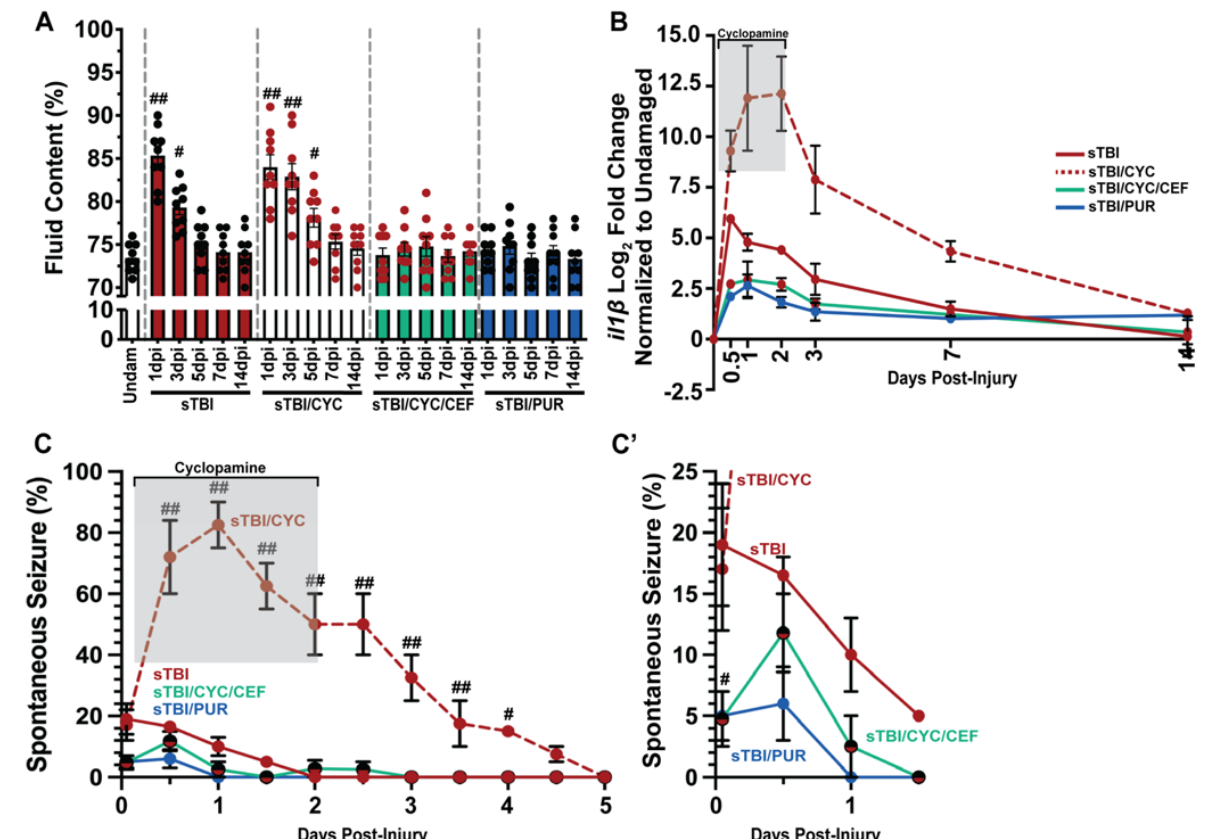
Figure 5. Prophylactic Shh activation attenuates TBI-induced edema, neuroinflammation, and PTS. ( A ) Histogram quantifying brain edema in undamaged and sTBI fish with and without Shh mod- ulation and ceftriaxone treatment across 1 to 14 dpi ( n = 9 fish per control/experimental group). ( B ) Expression of il1 β by qRT-PCR in the cerebellum of sTBI fish with and without Shh modulation and ceftriaxone treatment compared undamaged fish ( n = 3 per control/experimental group, with 5 pooled cerebellums/trial). ( C ) Percentage of fish that displayed spontaneous seizure events span- ning the timeframe of from within 1 hpi to 5 dpi with and without Shh modulation and ceftriaxone treatment ( n = 100 fish per control/experimental group). ( C’ ) Expanded view of early post-traumatic seizure percentage. Grey box denotes period of cyclopamine administration. Statistical analyses were performed with either a one-way ANOVA followed by Tukey’s multiple comparison post hoc test ( A ), a two-way ANOVA followed by Dunnett’s multiple comparison post hoc test ( B ), or the Friedman test of the repeated-measures data ( C ), # p < 0.05, ## p < 0.01.